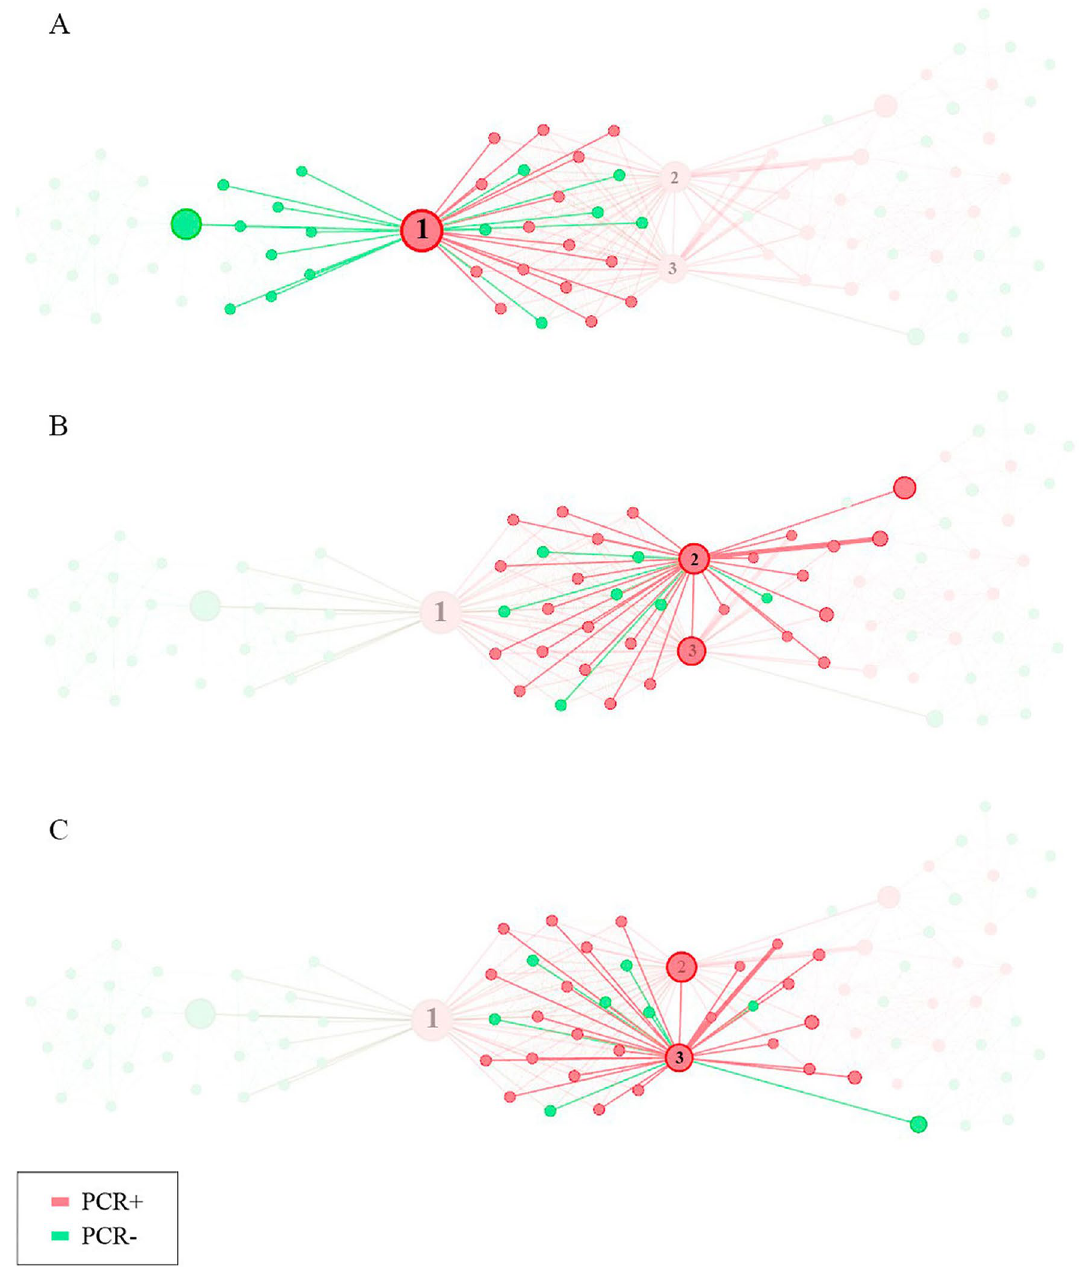
Figure 3. Egonetworks of the 3 main key players of the